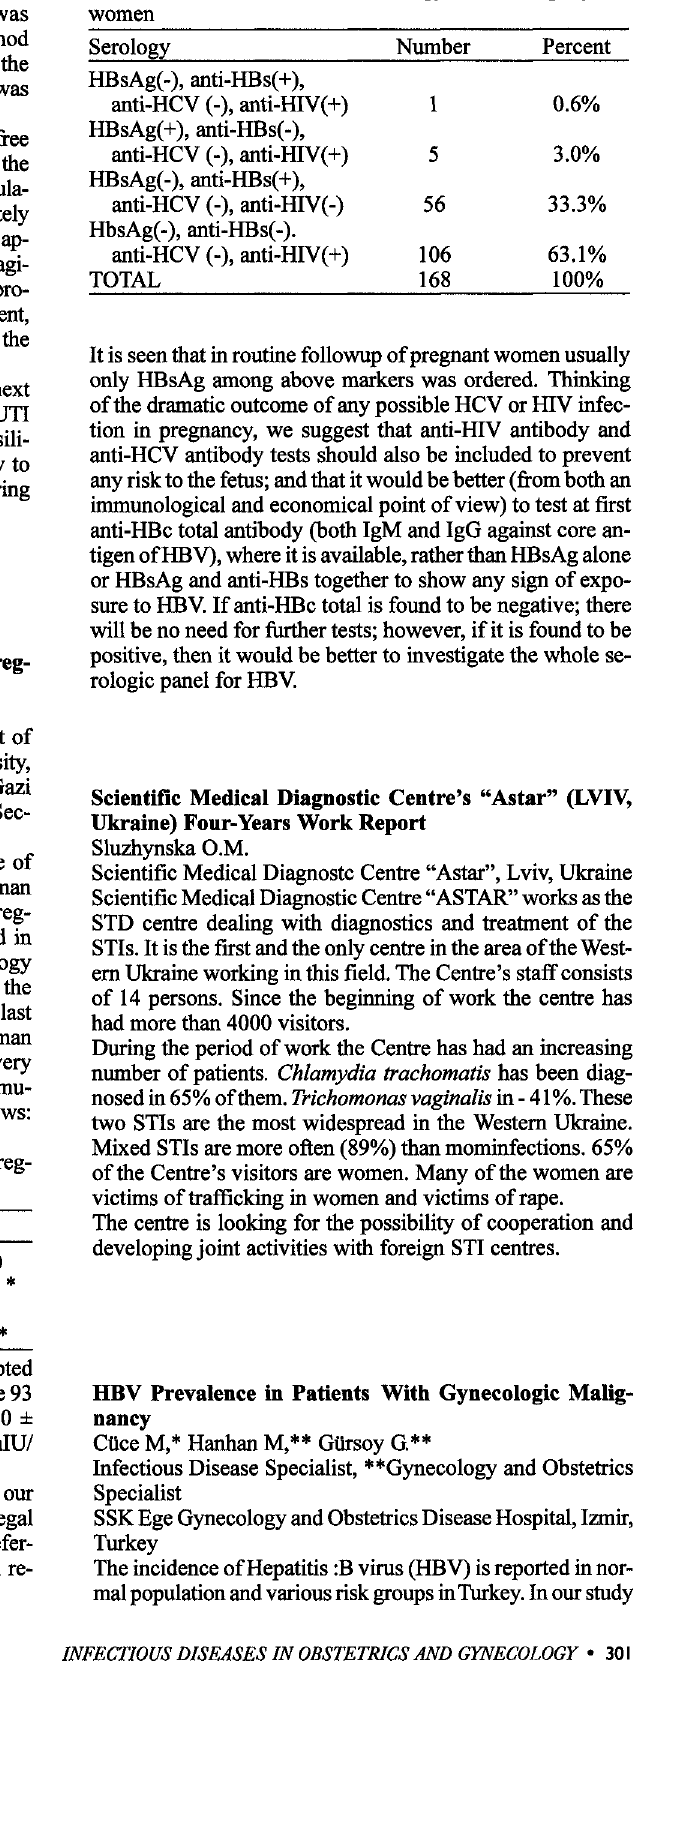
Table 2: HBV, HCV, and HIV serology ofthe 168